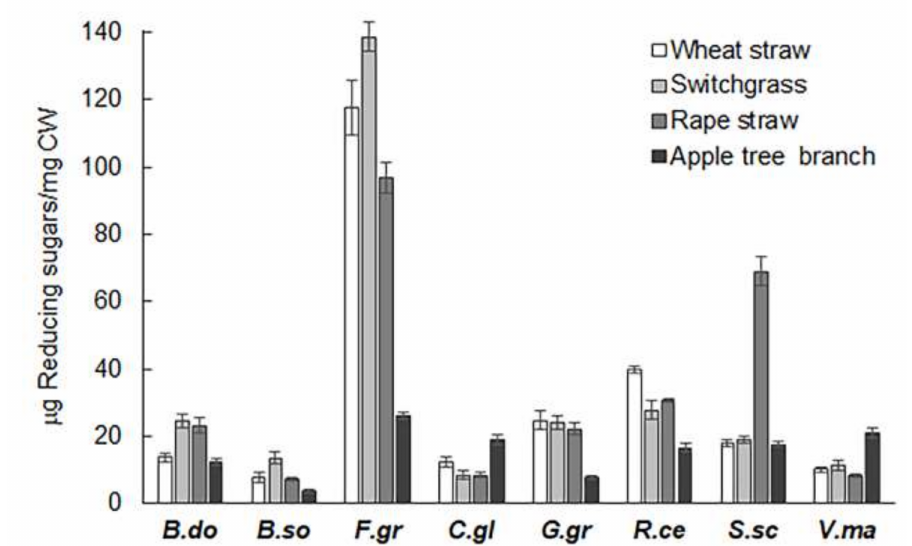
Figure 2. Enzymatic hydrolysis of cell wall substrates of wheat straw, switchgrass straw, rapeseed straw, and apple tree branch. Y axis depicts the amount of reducing sugars released after incubation of untreated cell wall substrates with extracts from the cultures of pathogenic fungi grown on switchgrass, as described previously